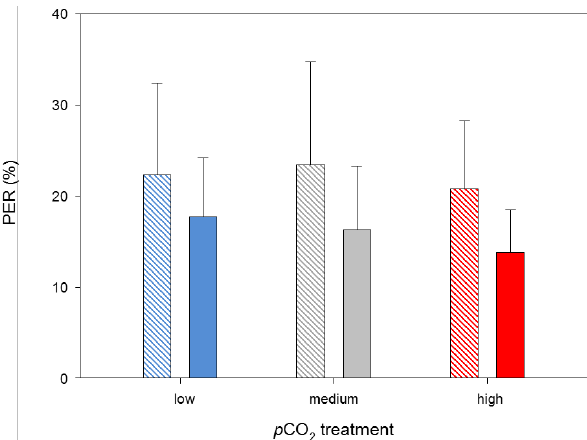
Fig. 6. Exudation of DOC calculated as percentage of extracellular release (PER) and averaged for grouped treatments (low, medium, high p CO 2 ) for the time before nutrient addition (hatched bars, day 5–day 12, n = 12), and after nutrient addition (solid bars, day 14–day 28; n = 21). For color information see Fig. 3. PER was not significantly different before nutrient addition, but decreased thereafter with increasing p CO 2 (t-test, p < 0.05).